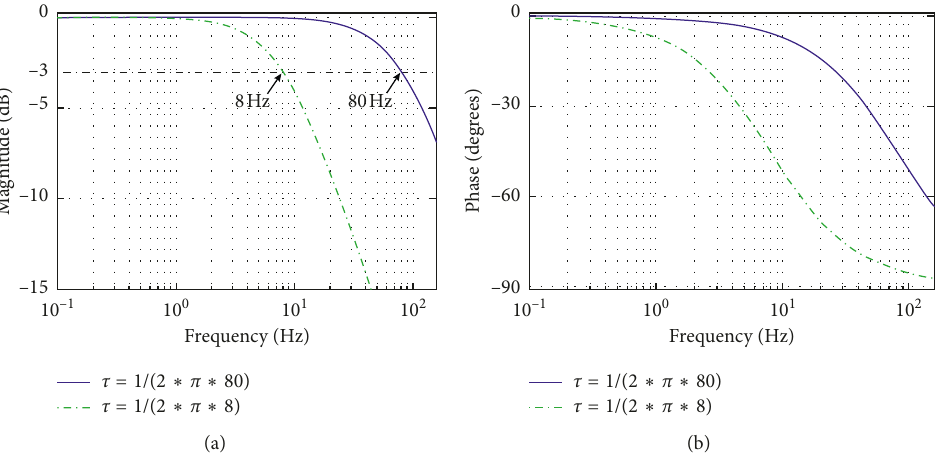
Figure 10: Bode diagram of the CACS under two different τ .